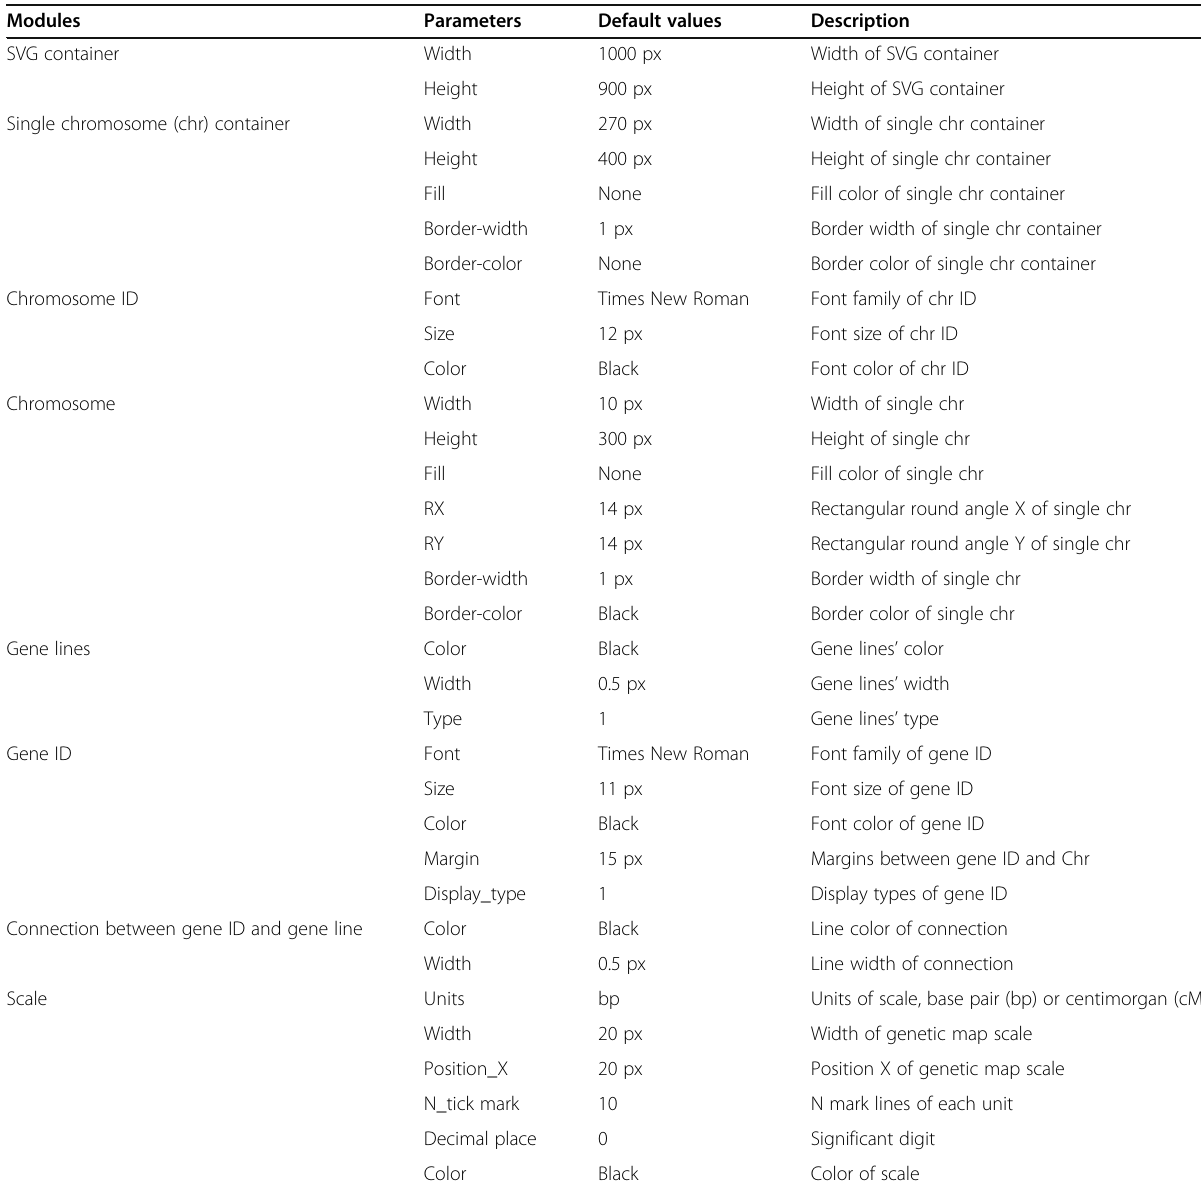
Table 1 Default values and description of MG2C main parameters